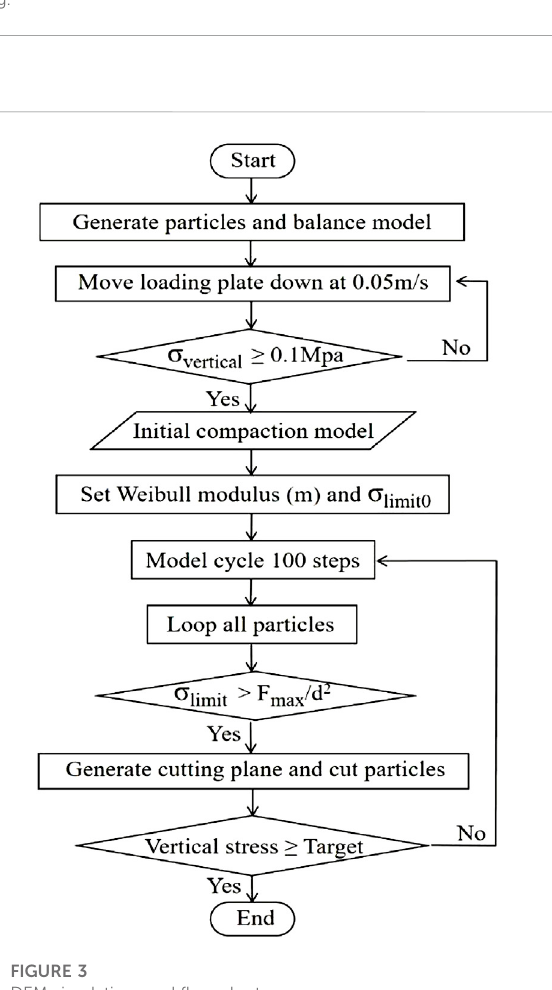
FIGURE 3 DEM simulation work fl ow